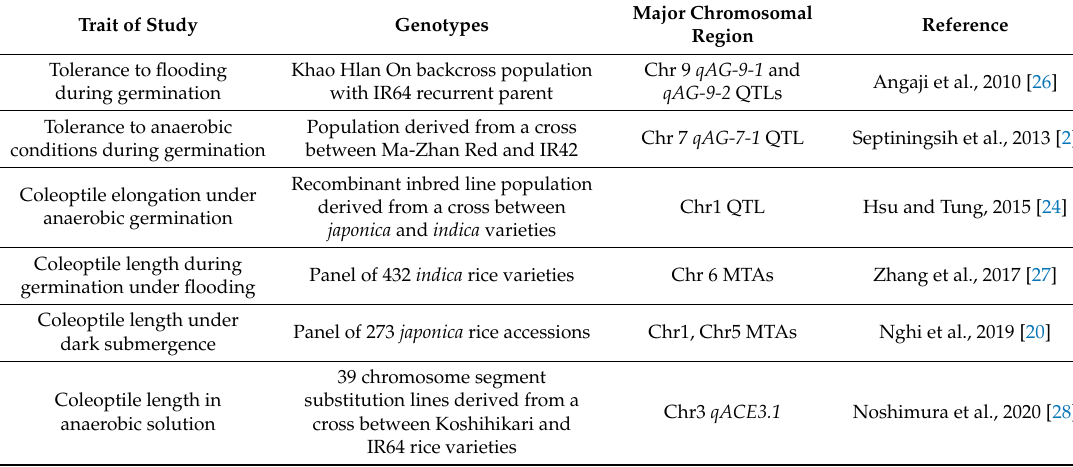
Table 1. Chromosomal regions identified in genetic studies focused on rice germination and coleoptile elongation